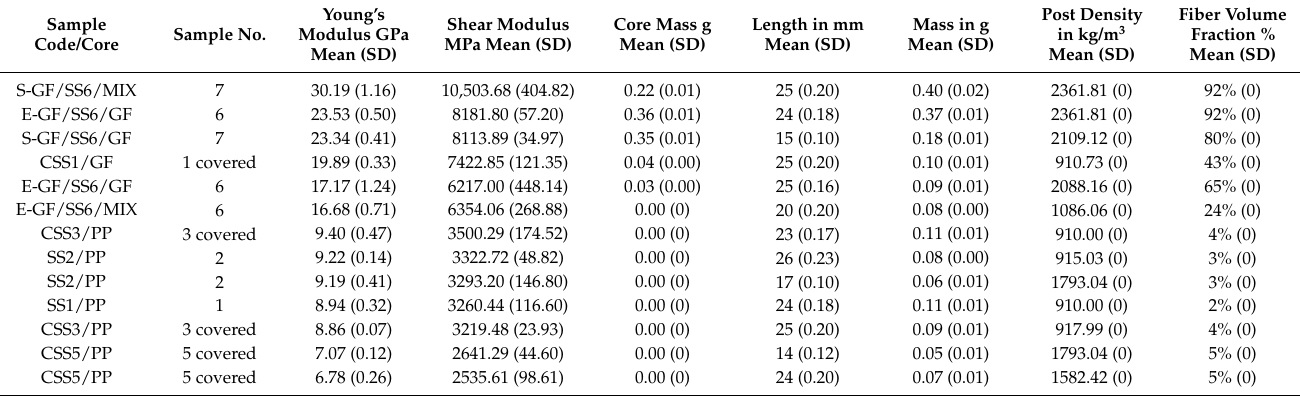
Table 7. The highest and lowest groups regarding the posts’ Young’s